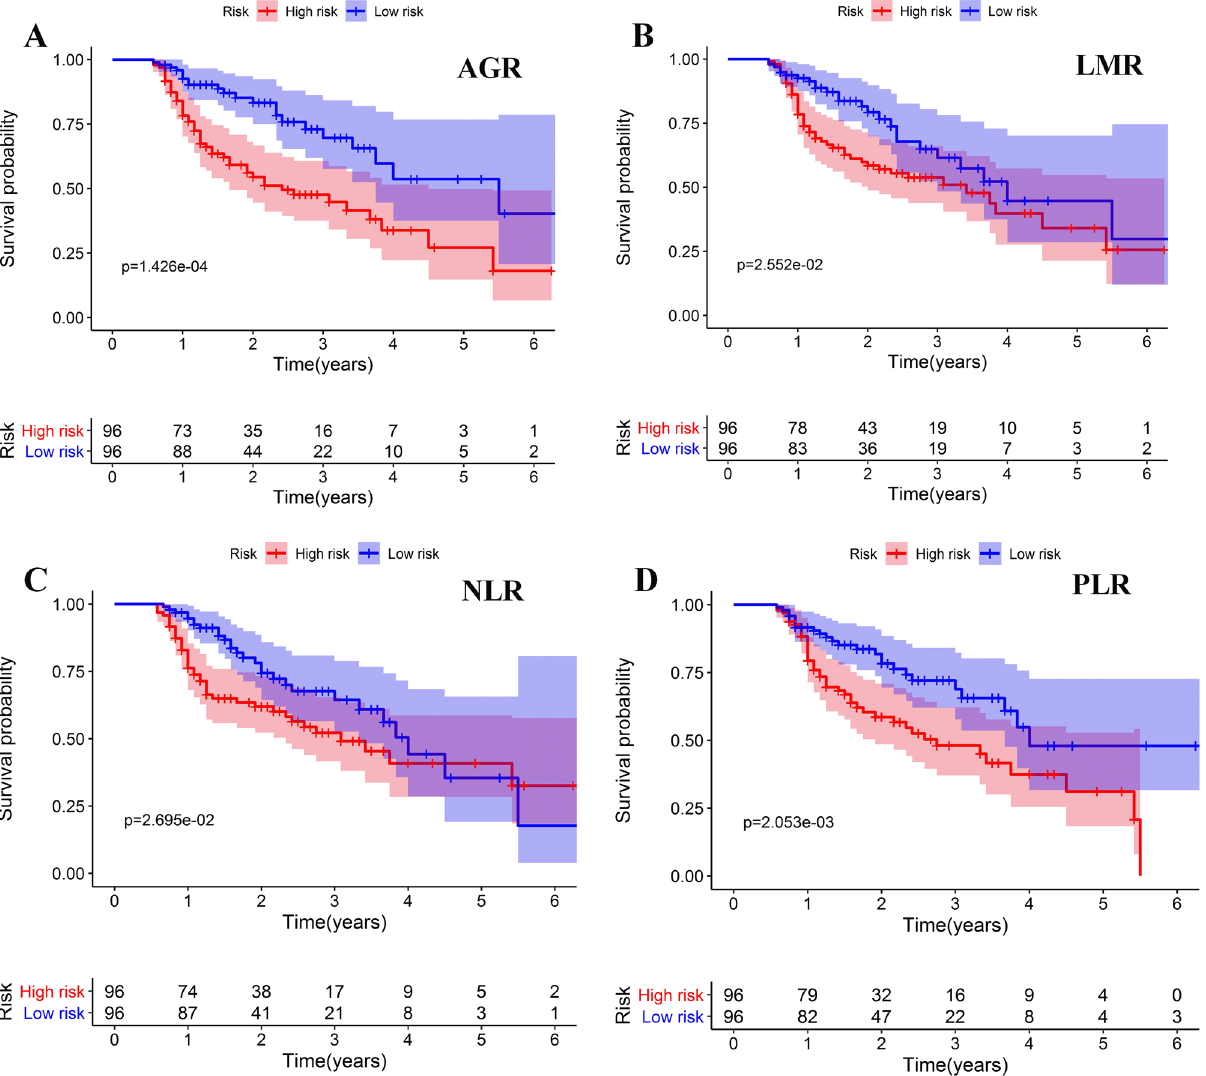
Figure 3. Kaplan–Meier curves for OS stratified by AGR (A) , LMR (B) , NLR (C) , and PLR (D) . The figure was performed using R software (version 3.3.1, Vienna, Austria, https:// www.r- proje ct.